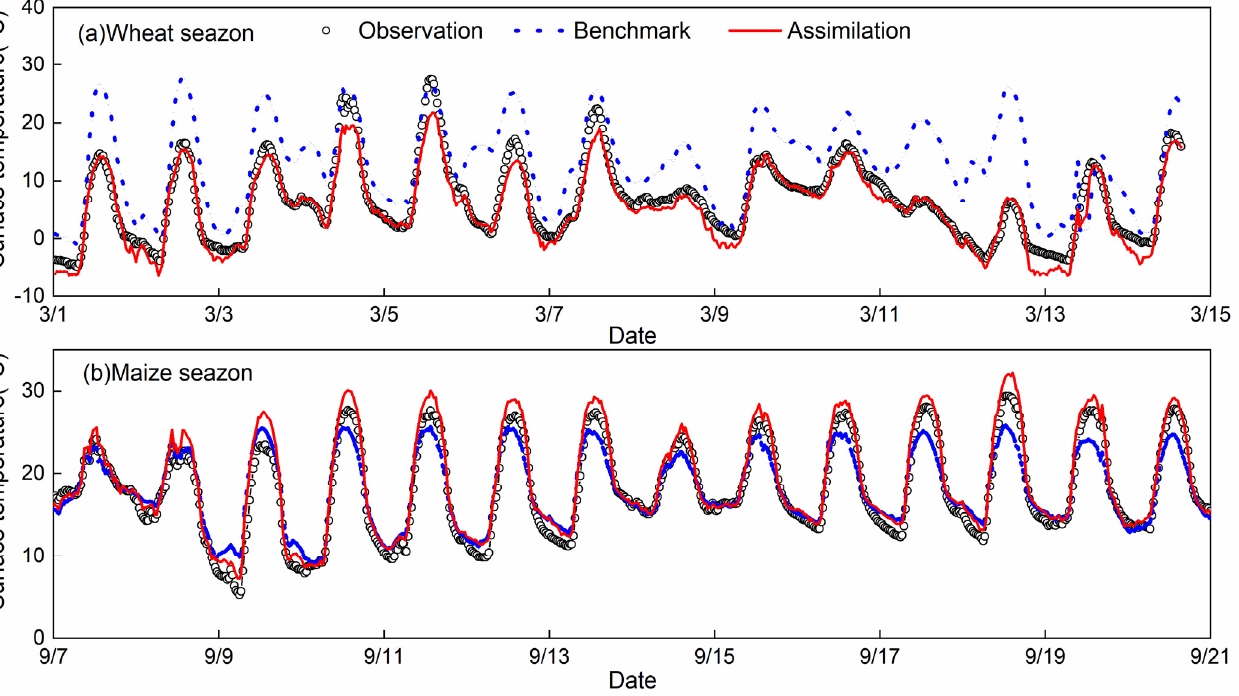
Figure 14. The two-week continuous simulation results for